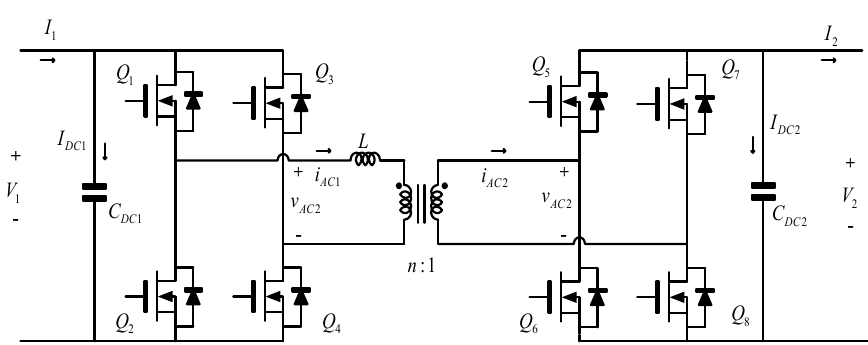
Figure 16. Single–phase Dual Active Bridge (DAB) converter [30].